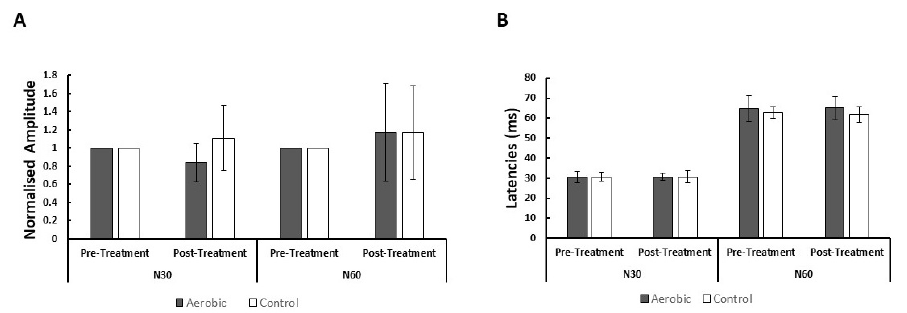
Figure 3. The graphs show changes in SEP normalized peak amplitudes pre and post both the aerobic exercise and control interventions ( A ) and SEP peak latencies (ms) pre and post both the aerobic exercise and control interventions ( B ) analyzed from the FC3 channel. Significance was set at p < 0.05 for all tests.